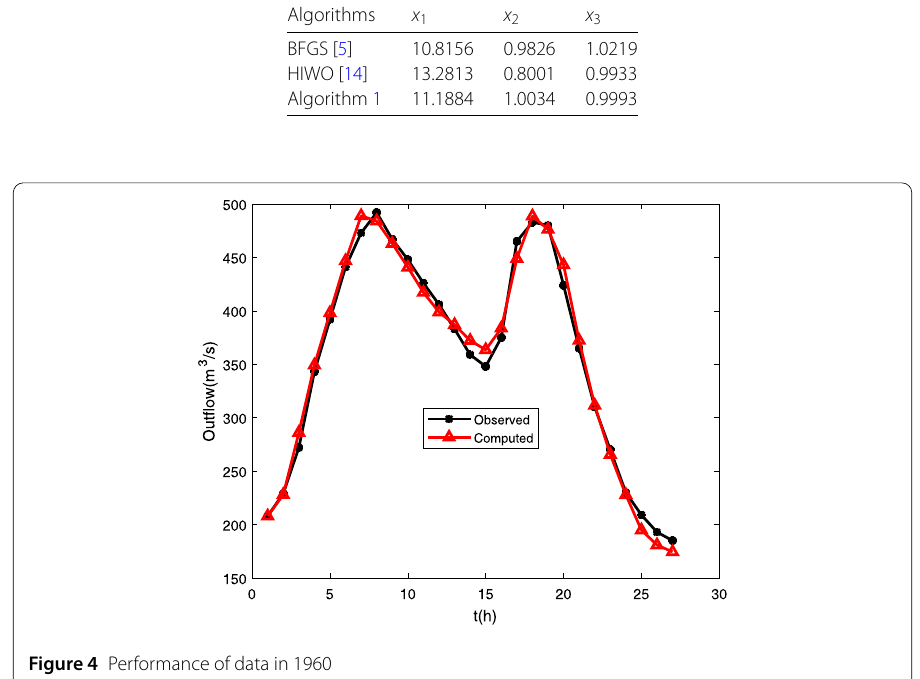
where x 1 is the storage time constant, x 2 is the weighting factor, and x 3 is an additional parameter; at time t i ( i = 1,2,..., n ), n denotes the total time number, (cid:9) t is the time step, I i and Q i are the observed inflow discharge and observed outflow discharge,